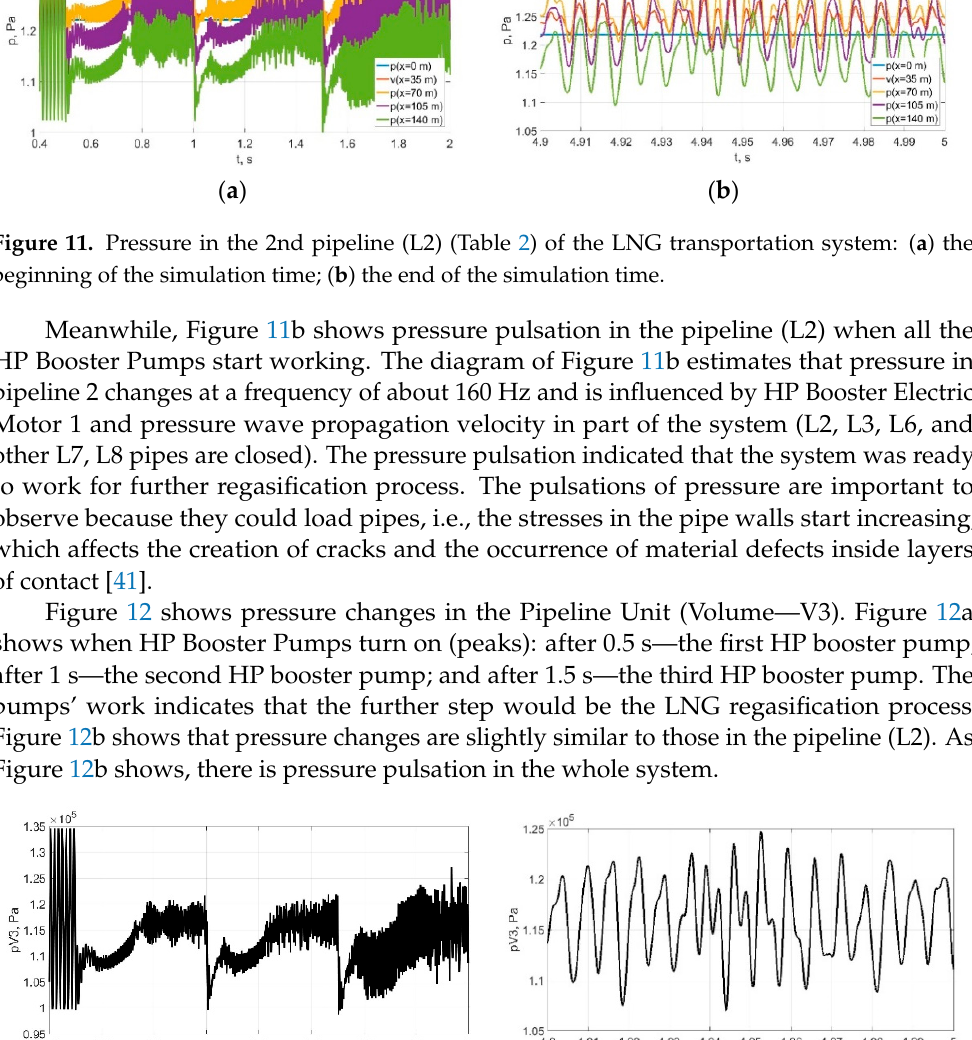
Figure 11. Pressure in the 2nd pipeline (L2) (Table 2) of the LNG transportation system: ( a ) the